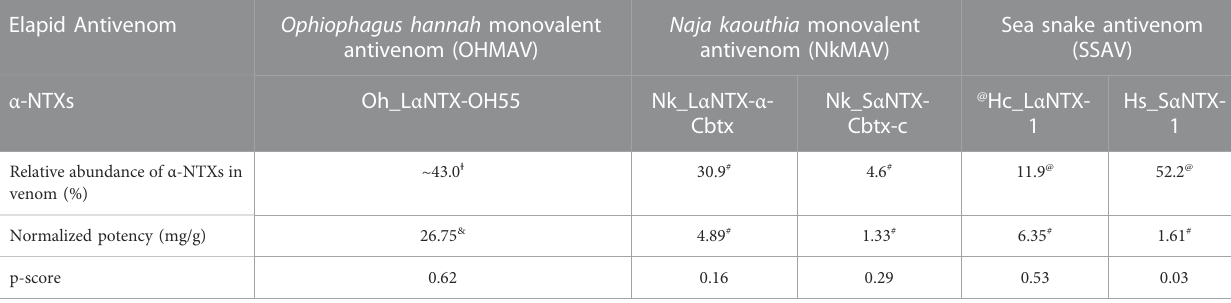
TABLE 3 Correlation of neurotoxin abundance and neutralization ef fi cacy of its homologous antivenom.